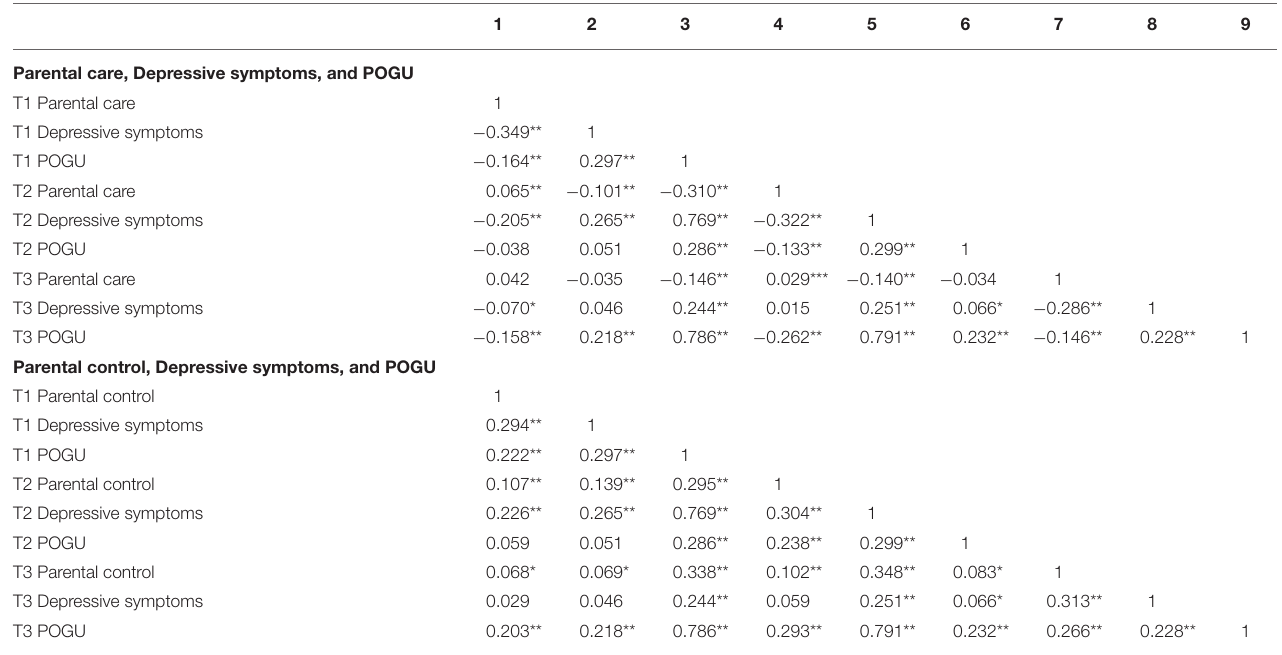
TABLE 2 | Intercorrelations among study